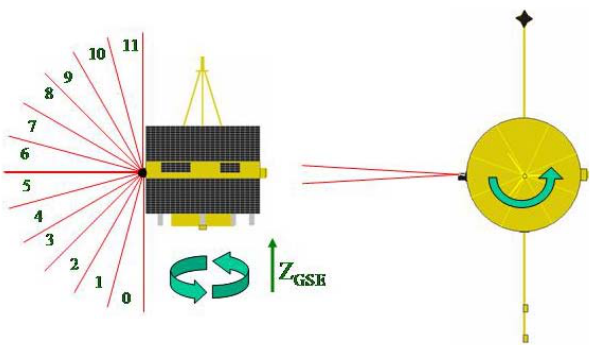
Fig. 2. Illustration of instantaneous field of view of a Double Star PEACE sensor. Left: Side view of spacecraft, spin axis points close to Z GSE , the “look” directions from which electrons arrive to be measured by the 12 anodes are indicated. Right: Top view of spacecraft, showing instantaneous field of view (elevation acceptance angle) also illustrating configuration of magnetometer booms (note that on TC-1 the STAFF boom is not deployed).